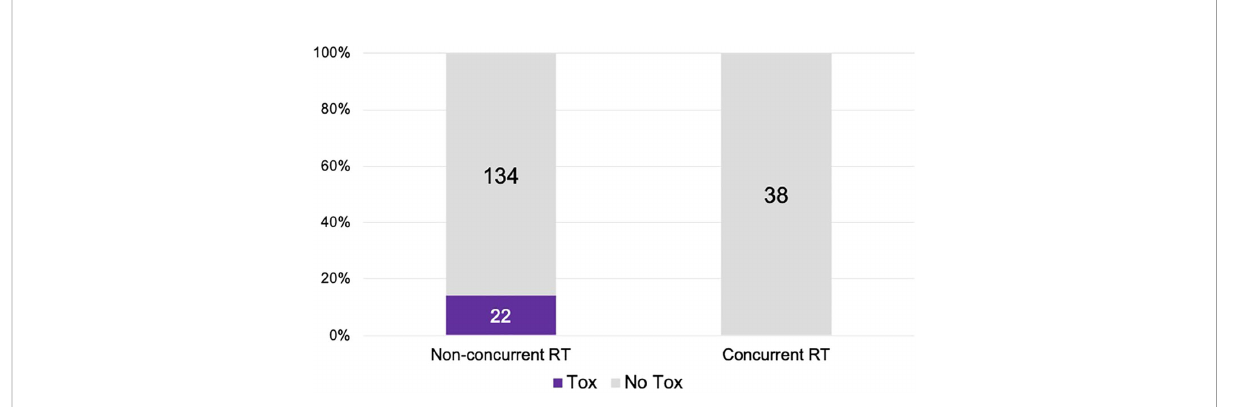
FIGURE 3 The plot of cardiotoxic events in patients who received ICI concurrent with thoracic RT versus ICI not concurrently with thoracic RT. Patients who received ICI non-concurrently with thoracic RT had higher rates of cardiotoxicity (p=0.030).